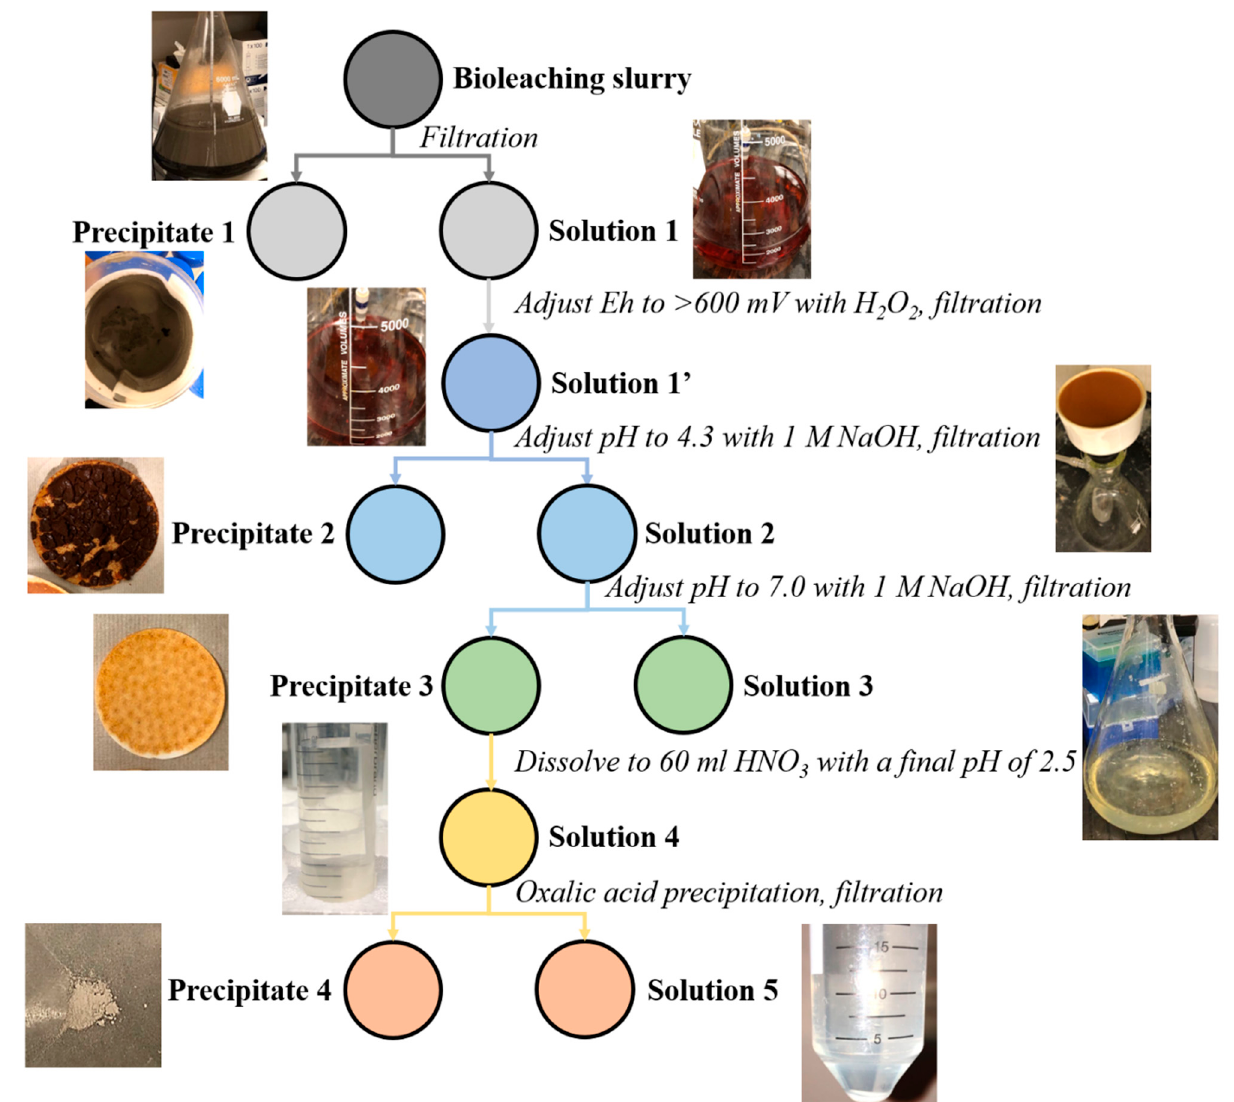
Figure 2. The flow chart of the bioleaching and REE precipitation tests and pictures from the test.